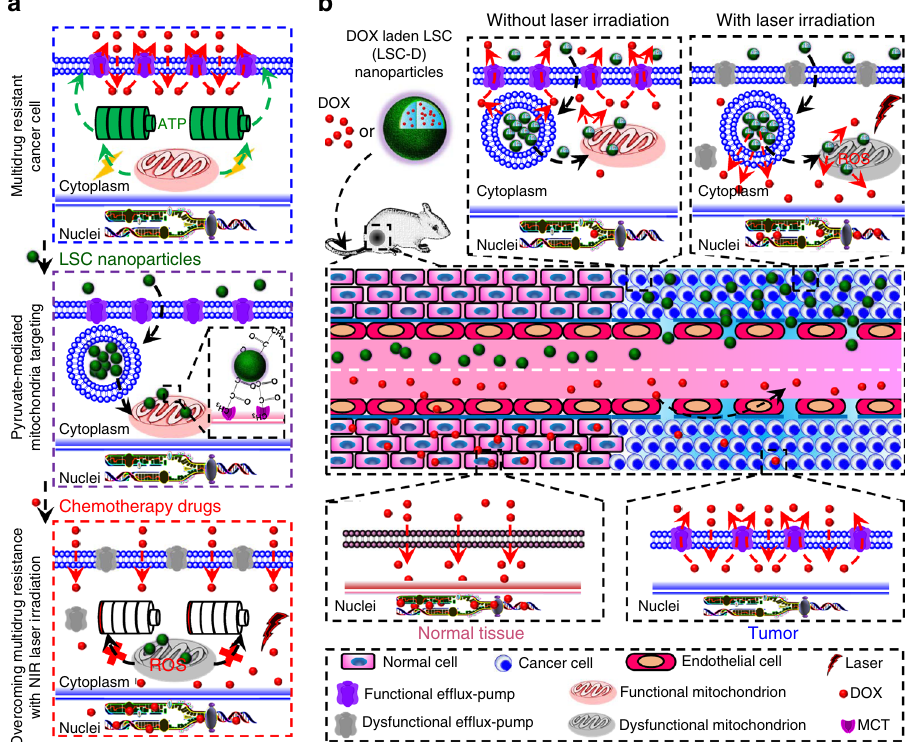
Fig. 1 A schematic illustration of the strategy for overcoming cancer drug resistance. a The transmembrane P-glycoprotein (P-gp) ef fl ux pump driven by adenosine triphosphate (ATP) is a major mechanism of cancer multidrug resistance. In this study, a novel lipid membrane-coated silica-carbon (LSC) nanoparticle is designed to target the monocarboxylate transporters (MCTs) on mitochondria through the pyruvate groups on the surface of the LSC nanoparticle. With near infrared (NIR, 800 nm) laser irradiation, the LSC nanoparticles produce reactive oxygen species (ROS) to oxidize NADH into NAD + in mitochondria, which compromises ATP production. This results in dysfunction of the P-gp ef fl ux pumps. In addition, the treatment of LSC nanoparticles with NIR laser irradiation (LSC + L) leads to not only transmembrane but also intracellular distribution of the P-gp ef fl ux pumps, although the total amount of the ef fl ux pumps is only slightly (albeit signi fi cantly) reduced. Collectively, the LSC + L treatment can be used to overcome the multidrug resistance of cancer cells, which is demonstrated using three different chemotherapy drugs in this study: doxorubicin hydrochloride (DOX), paclitaxel (PTX), and irinotecan (CPT-11). b Owing to their nanoscale size (~45 nm), the DOX-laden LSC (LSC-D) nanoparticles can preferentially accumulate in tumor as a result of the enhanced permeability and retention (EPR) effect of tumor but not normal vasculature to minimize systemic toxicity of the chemotherapy drug. After arriving in tumor, the LSC-D nanoparticles can be taken up by multidrug-resistant cancer cells, but the DOX released out of the nanoparticles can still be pumped out of the cells for the LSC-D treatment alone. Importantly, with NIR laser irradiation, the drug resistance of the multidrug-resistant cancer cells can be overcome and effective tumor destruction ensues. In contrast, free DOX can diffuse into both normal tissue (which causes systemic toxicity) and the multidrug-resistant tumor. Moreover, free DOX can be pumped out of the multidrug-resistant cancer cells and further diffuse back into blood perfusion, leading to ineffective cancer therapy. All mouse and mitochondrion images were created using ChemBioDraw Ultra 12.0 and their color was further adjusted in